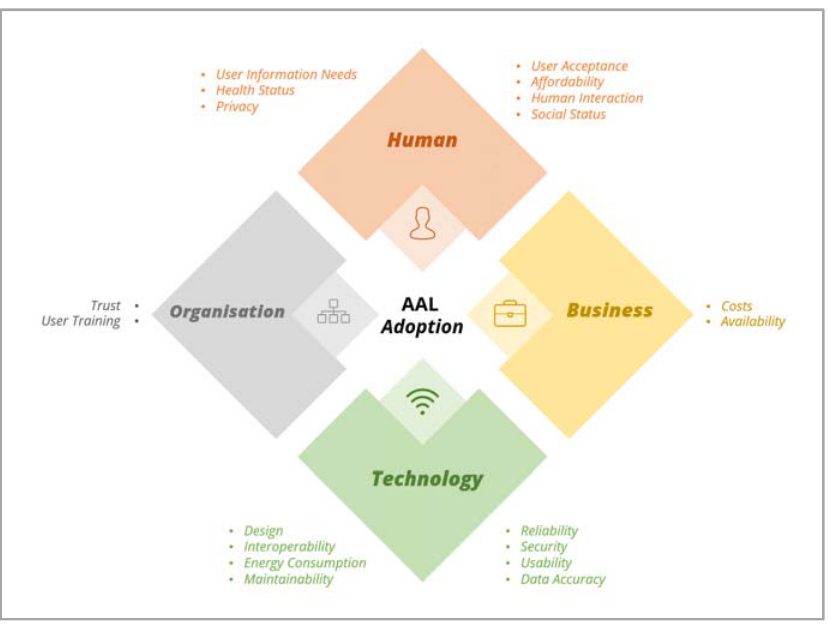
Figure 4. AAL Adoption Diamond